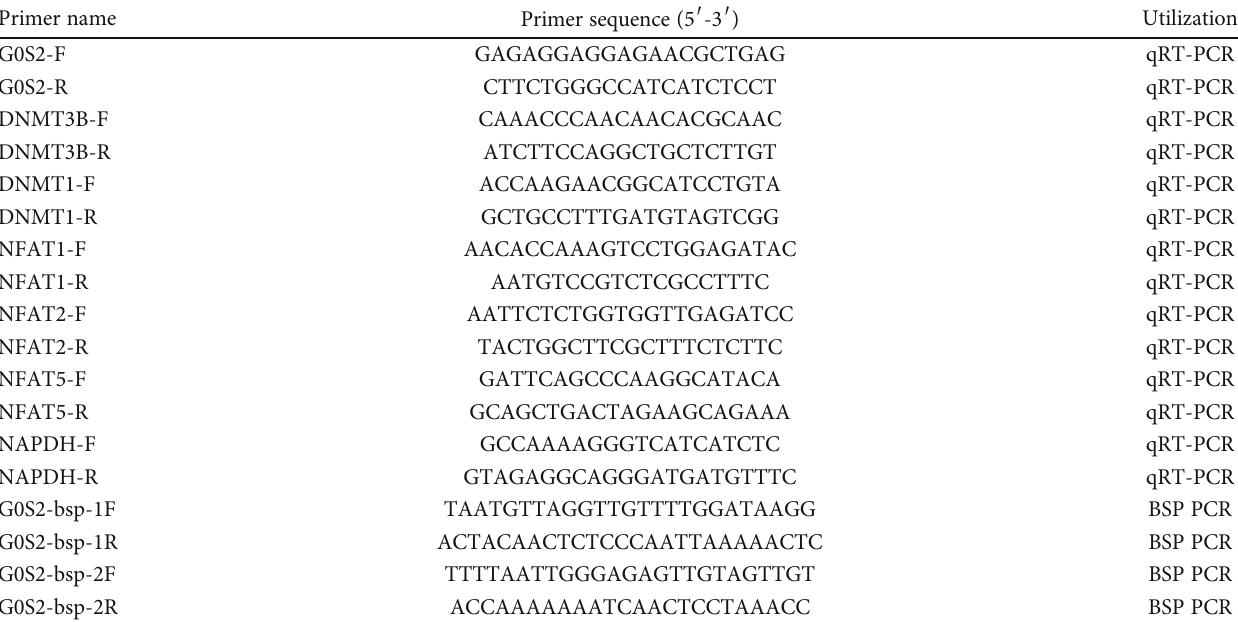
Table 1: Primers used in the